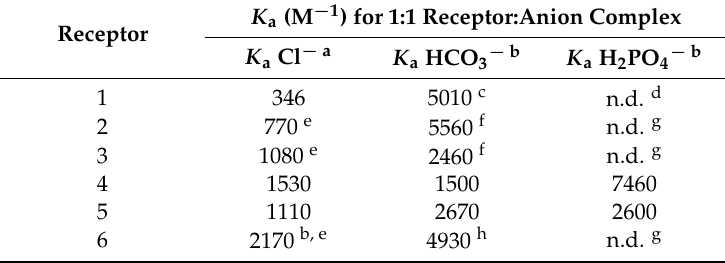
Table 1. Stability constants ( K a ) for the complexation of receptors 1 – 6 with chloride, bicarbonate, and dihydrogen phosphate (as TBA salts for chloride and dihydrogen phosphate and TEA for bicarbonate) in DMSO- d 6 /0.5% H 2 O at 298